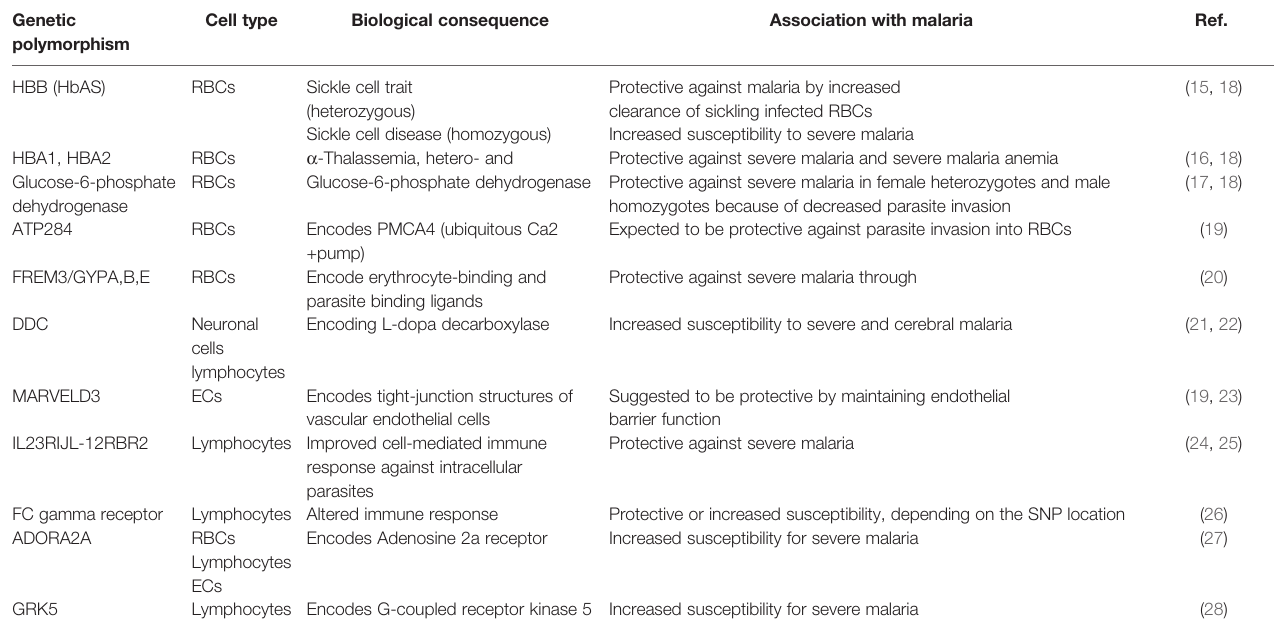
TABLE 1 | Genetic variations and their association to malaria. Genetic